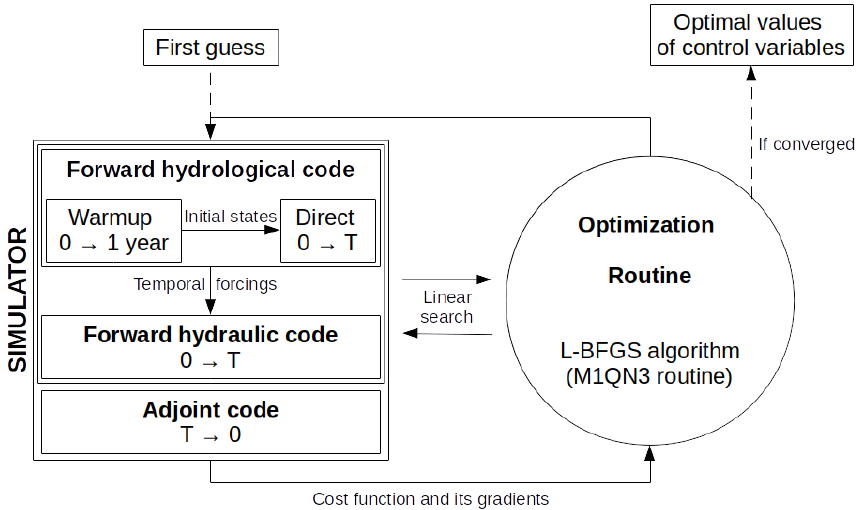
Figure 5. Complete VDA hydraulic–hydrological tool